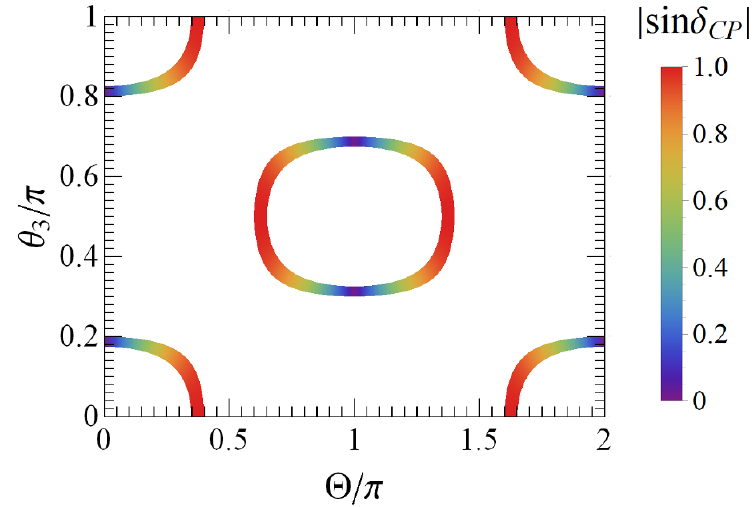
Figure 1 . Regions in the (cid:18) 3 (cid:0) (cid:2) plane allowed by current neutrino oscillation data on sin 2 (cid:18) 12 at 3 (cid:27) level [3]. The values of j sin (cid:14) CP j are indicated by the color shadings.